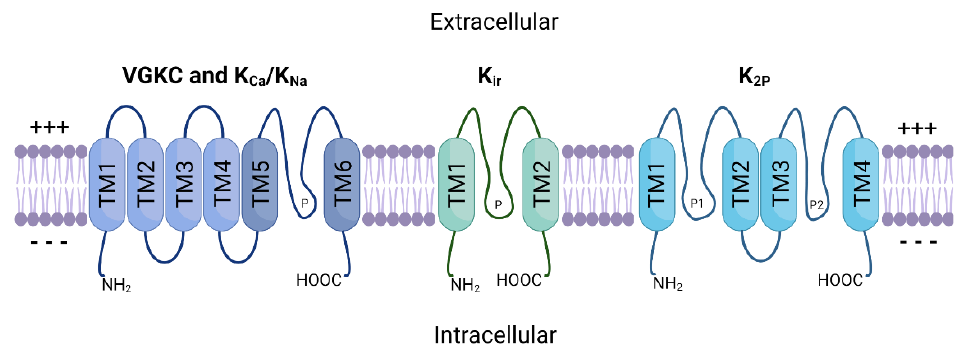
Figure 1. General schematic structure of the four major potassium channel subfamilies. TM1 – TM6 represent transmembrane segments and ‘P’ represents pore-forming regions between subunits. VGKC and K Ca channels share a common four subunit structure (TM1 – TM4) that comprises the selective voltage-sensing domain [32]. TM5 and TM6 correspond to the pore domain found in all K + channels [39]. K Na channels also follow this basic transmembrane structure but encode additional residues within the C-terminal region that regulate K + conductance [40]. K ir channels have two transmembrane domains and a single pore-forming region between them. K 2P channels are comprised of four TM domains and two separate pores. Modified from [41].+++: Positively-charged side; ---: Negatively-charged side.